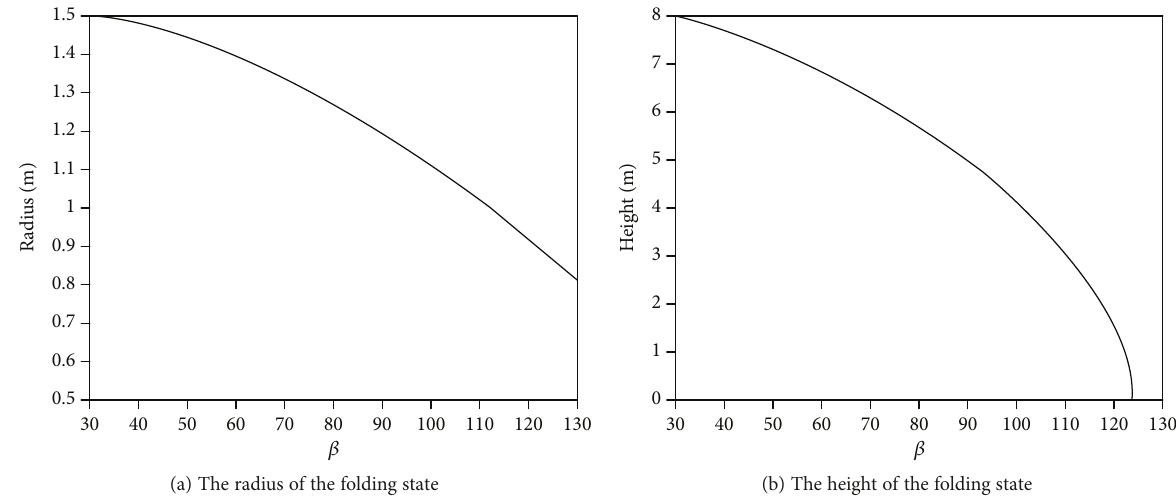
Figure 14: Relationship curve between the values of the angle and the folding states.